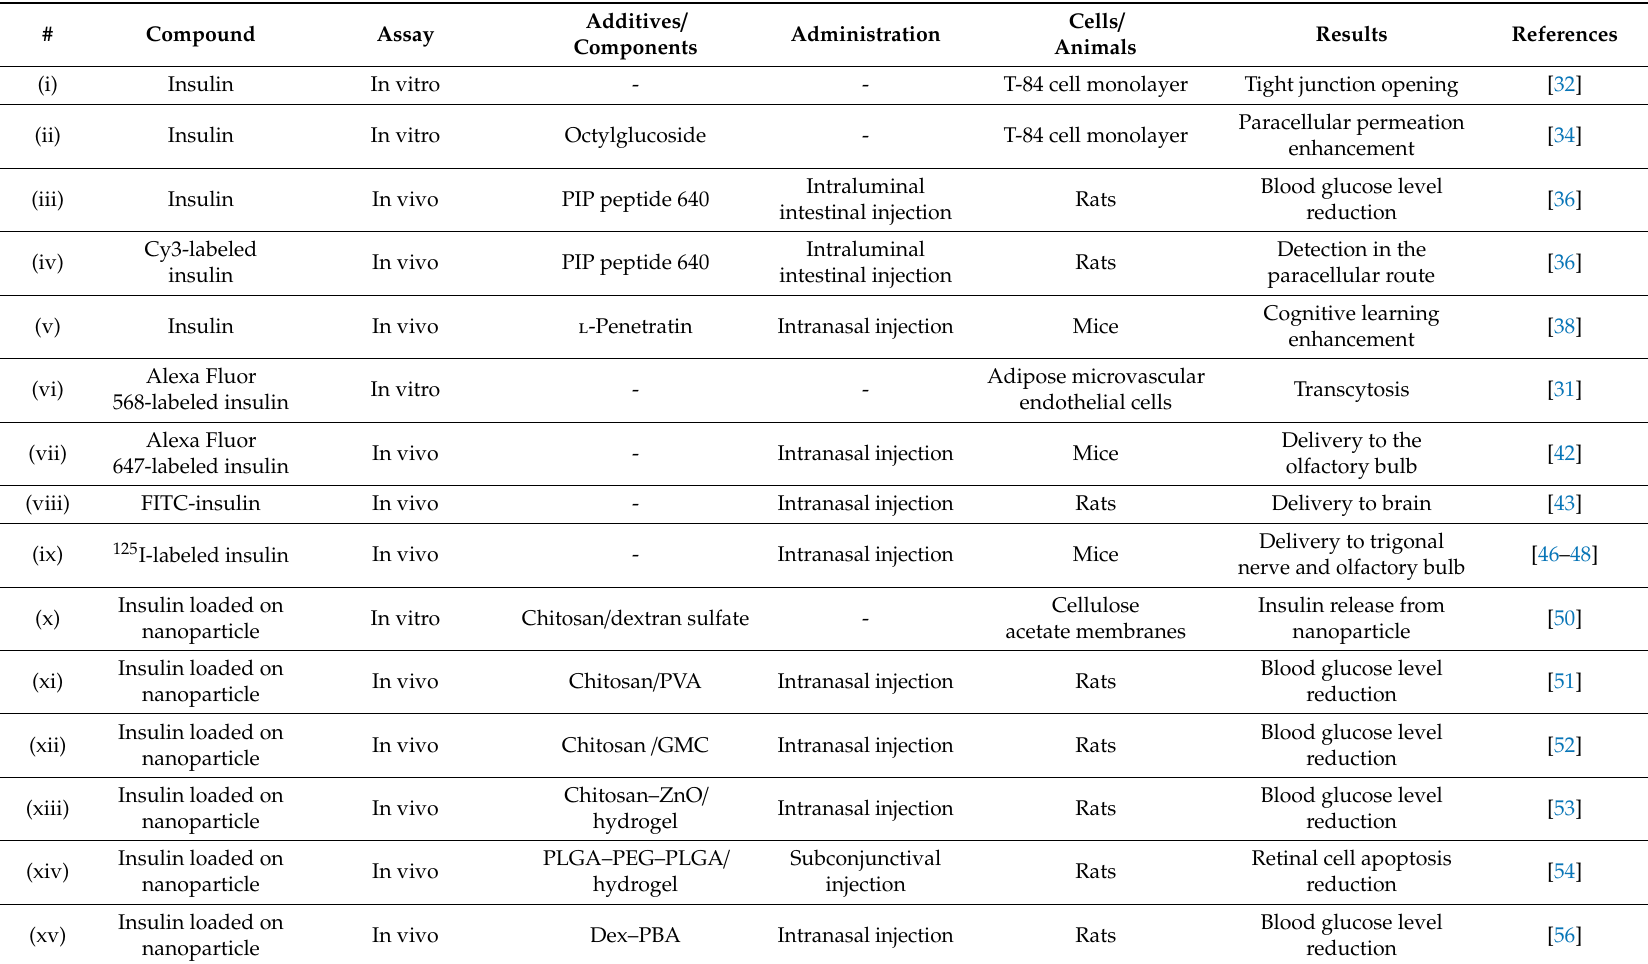
Table 2. Summary of the delivery approaches of insulin and its derivatives described in this